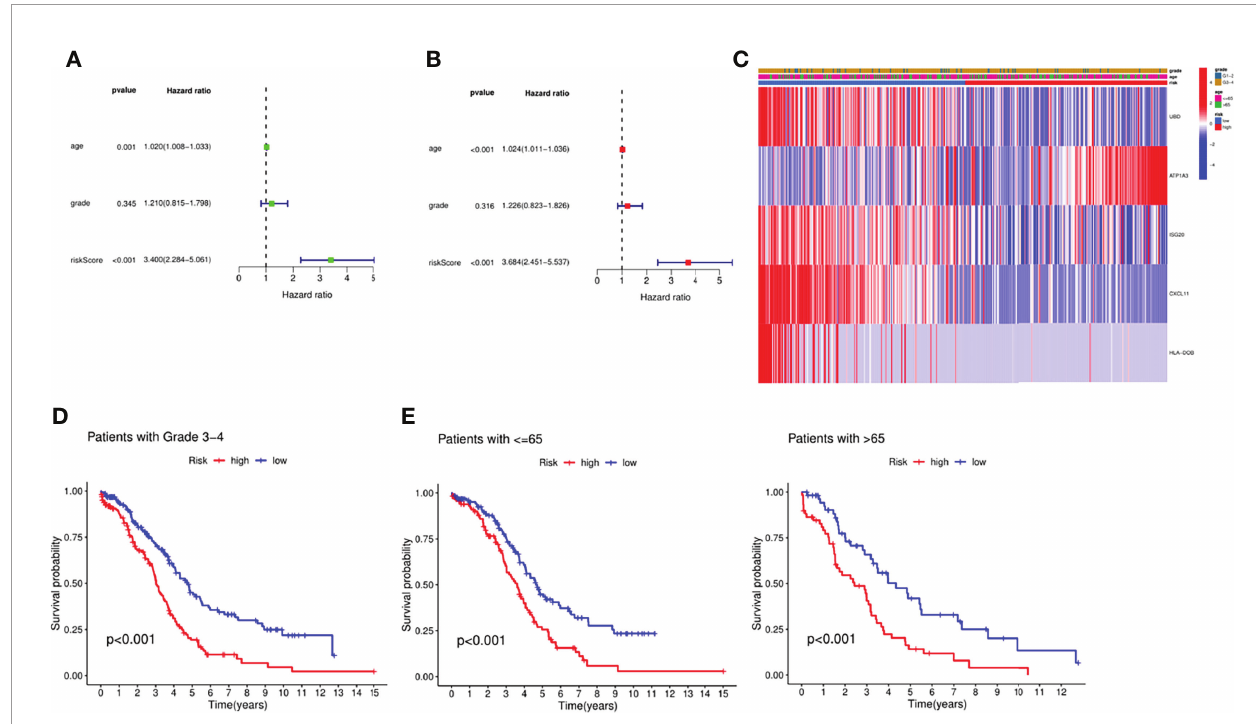
FIGURE 3 | Independent prognosis analysis of the signature. (A) Univariate analysis for the TCGA cohort. (B) Multivariate analysis for the TCGA cohort. (C) Heatmap integrated by the expression pro fi le and the clinical parameters. (D) Survival analysis between the groups with Stage III-IV. (E) Survival analysis between the groups with different